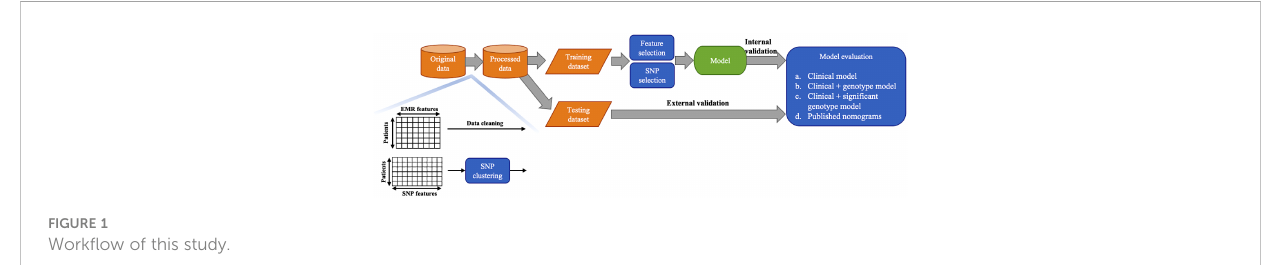
FIGURE 1 Work fl ow of this